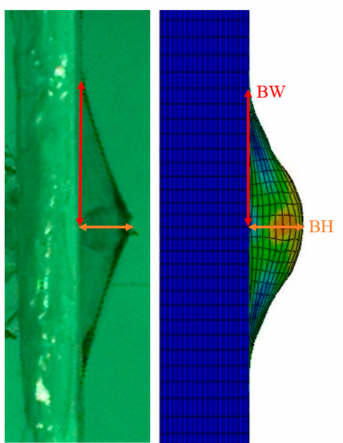
Figure 5. Bulge height—BH (orange) and bulge width—BW (red) are marked.